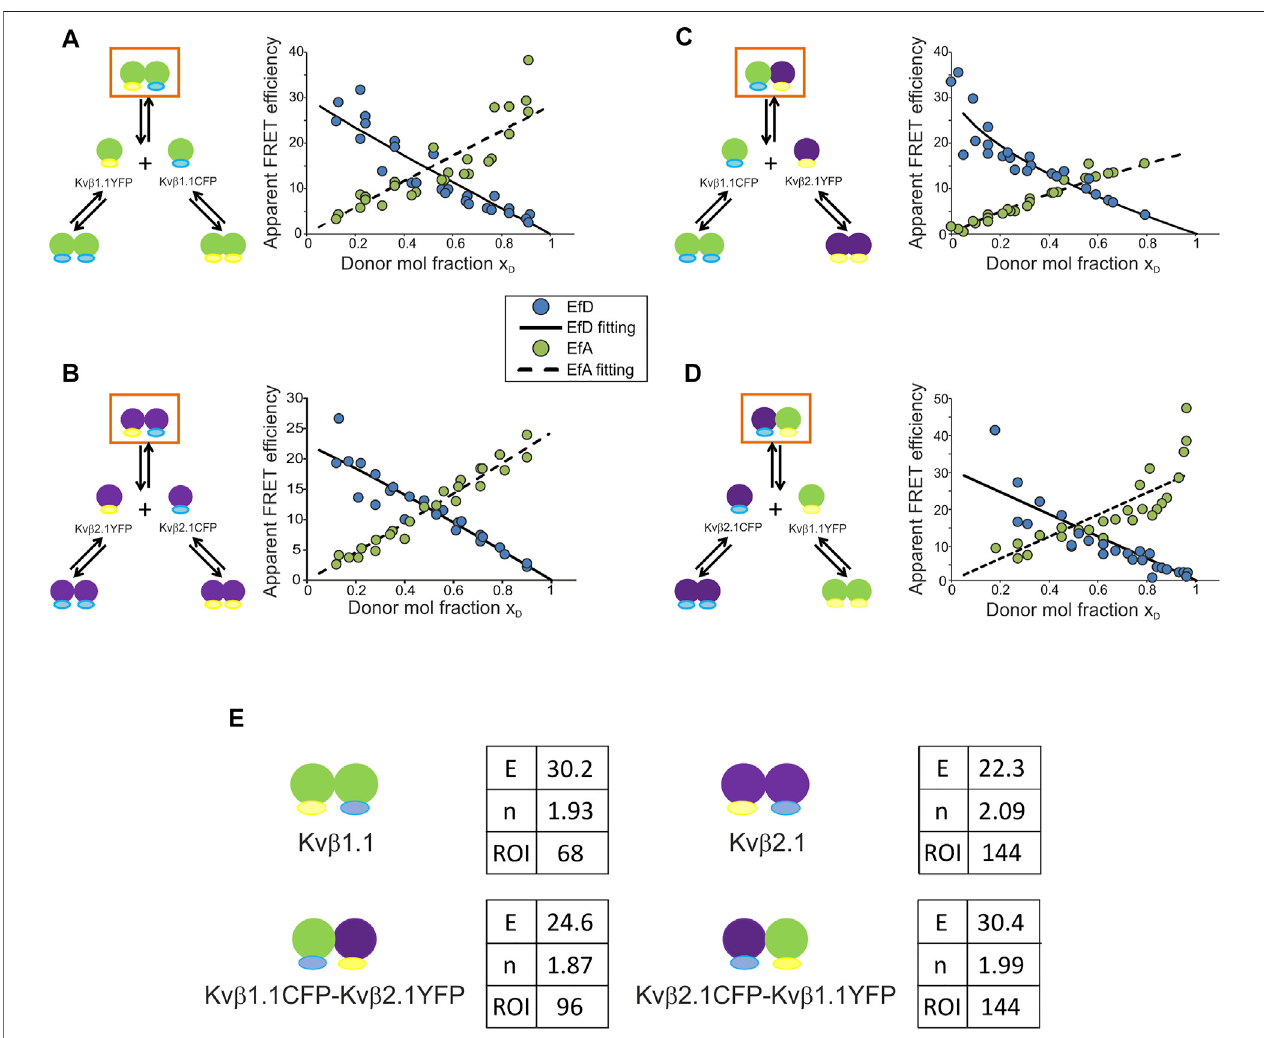
FIGURE3| Kv β 1.1 and Kv β 2.1 exhibithigh FRETef fi cienciesfor homo-and hetero-oligomerization withabasicunit oftwopeptidesper complex. (A) Kv β 1.1CFP/ Kv β 1.1YFP. (B) Kv β 2.1CFP/Kv β 2.1YFP. (C) Kv β 1.1YFP/Kv β 2.1CFP. (D) Kv β 1.1CFP/Kv β 2.1YFP. Left panels, schematic representation of possible interactions upon cotransfection. Right panels, plot of Ef D (blue circles), Ef D fi tting (solid line), Ef A (green circles), Ef A fi tting (dashed line) vs. the donor molar ratio (x D ). (E) Values obtained from lux-FRET experiments performed on Kv β combinations represented inorange squares in (A – D) . E,FRET ef fi ciency(%); N, number ofunits per complex;ROI, number of ROIs analyzed. Green shapes, Kv β 1.1; purple shapes, Kv β 2.1. Yellow represents YFP; blue represents CFP.